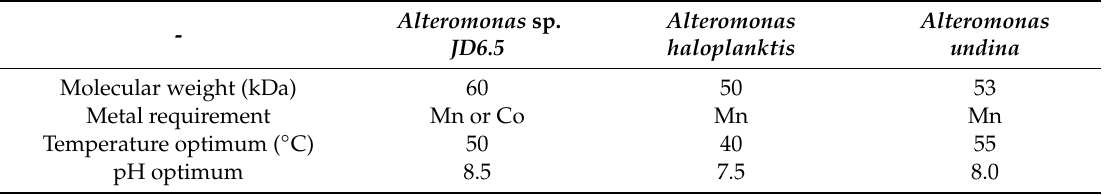
Table 1. Comparison of various Alteromonas OPAAs